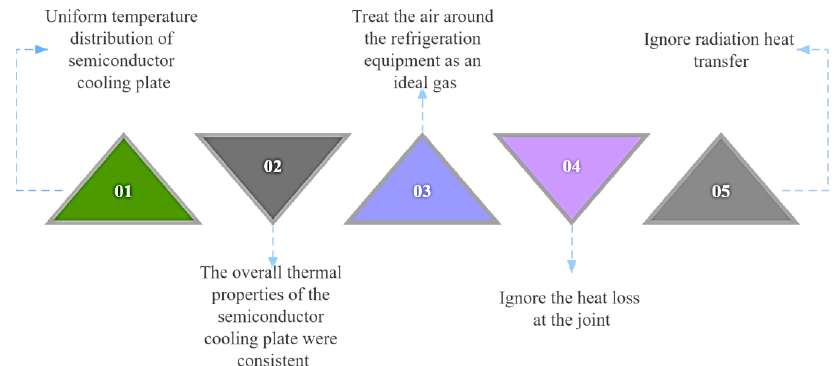
Figure 9. Model assumptions for CFD simulation.